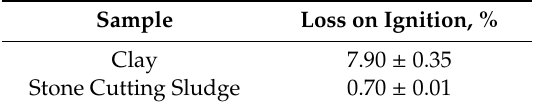
Table 3. Loss on ignition of clay and the stone cutting sludge.